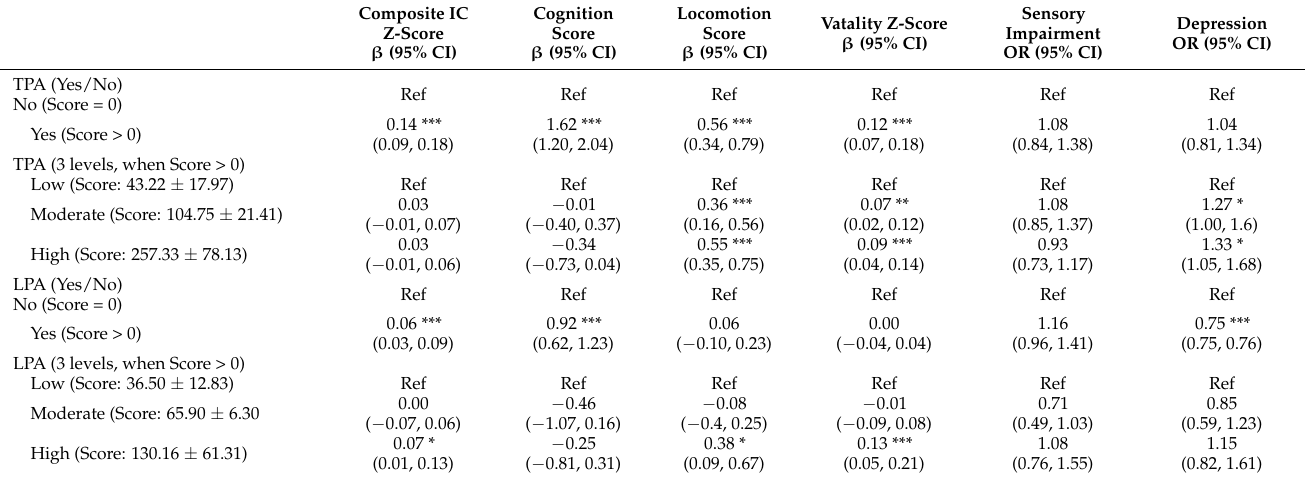
Table 3. Associations between PA and IC among older adults in CHARLS